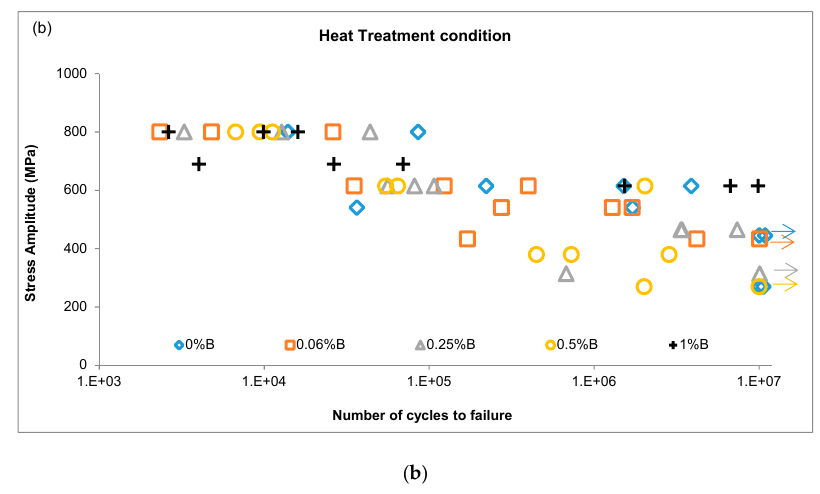
Figure 3. S-N diagrams of ( a ) as-cast and ( b ) heat treatment condition.